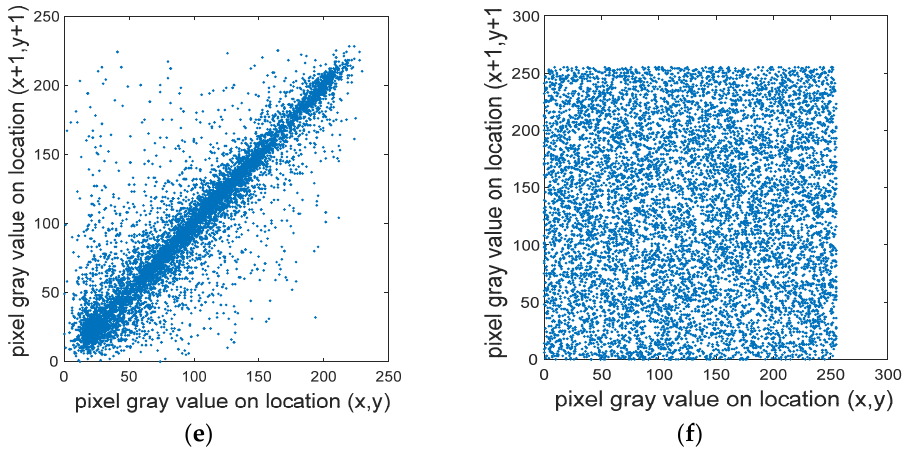
Figure 10. The level of adjacent-pixel correlation. ( a ) Lena plaintext; ( b ) Lena ciphertext horizontal correlation; ( c ) Lena plaintext vertical correlation; ( d ) Lena clear text vertical correlation; ( e ) Lena plaintext diagonal correlation; ( f ) Lena plaintext diagonal correlation. Table 2. Correlation between adjacent pixels of plaintext and ciphertext images.